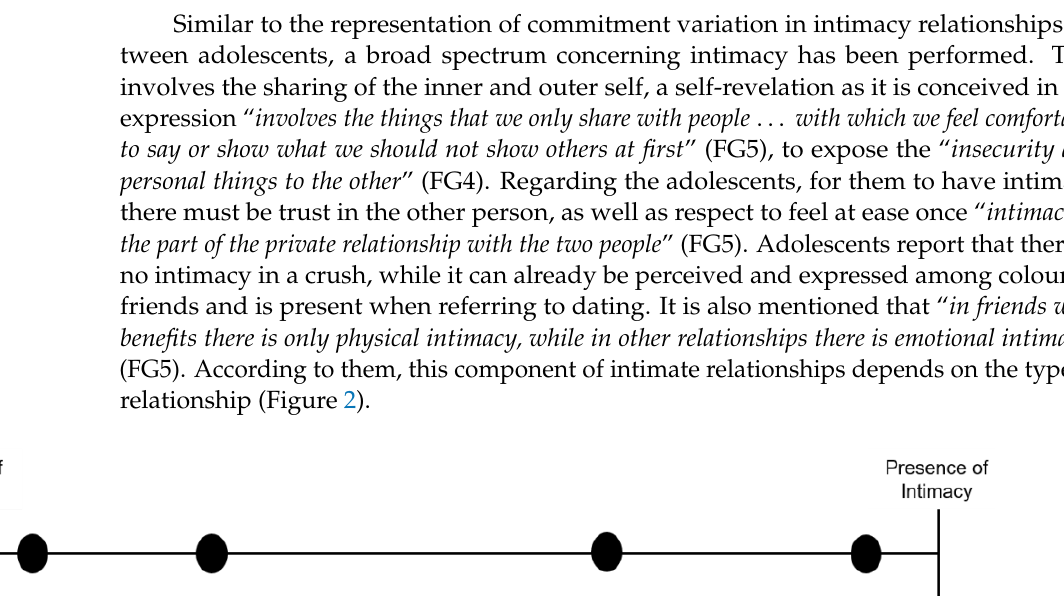
Figure 1. Spectrum of the representation of commitment in love relationships between adolescents.